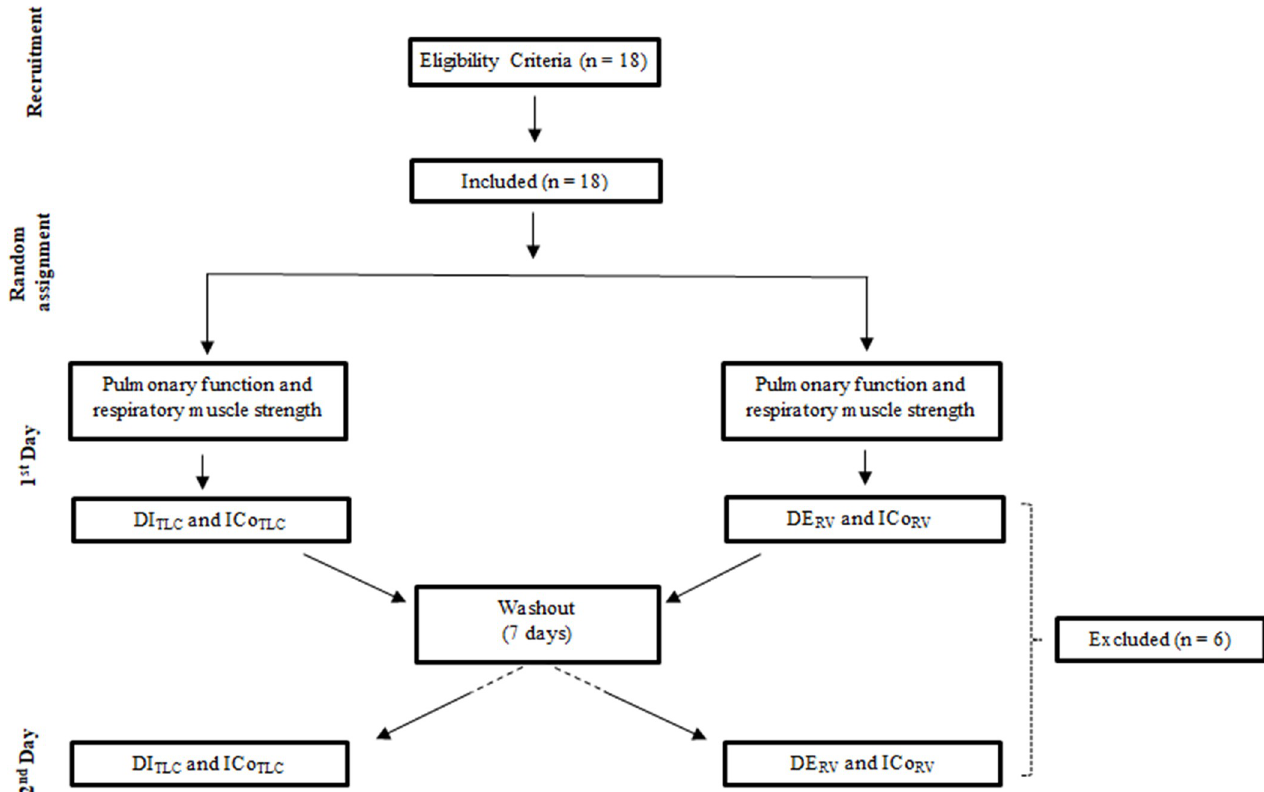
Fig 1. Flowchart of the study. DI TLC : Deep inspiration from total lung capacity; ICo TLC : Inspiratory contraction from full lung capacity; DE RV : Deep inspiration from residual volume; ICo RV : Inspiratory contraction from residual